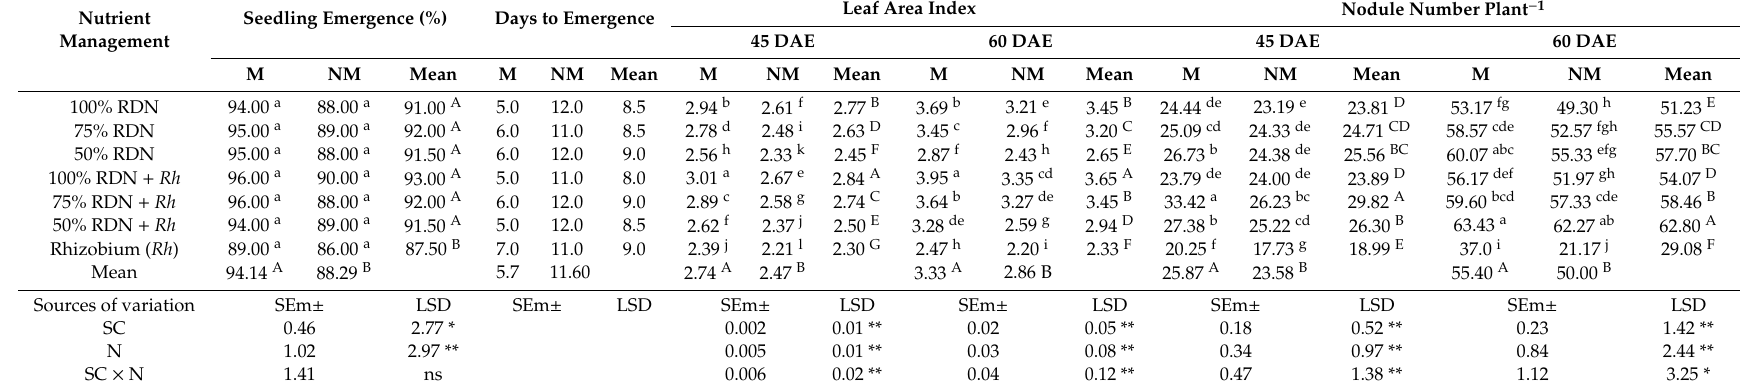
Table 2. E ff ect of soil mulch and nutrient management on peanut growth attributes in